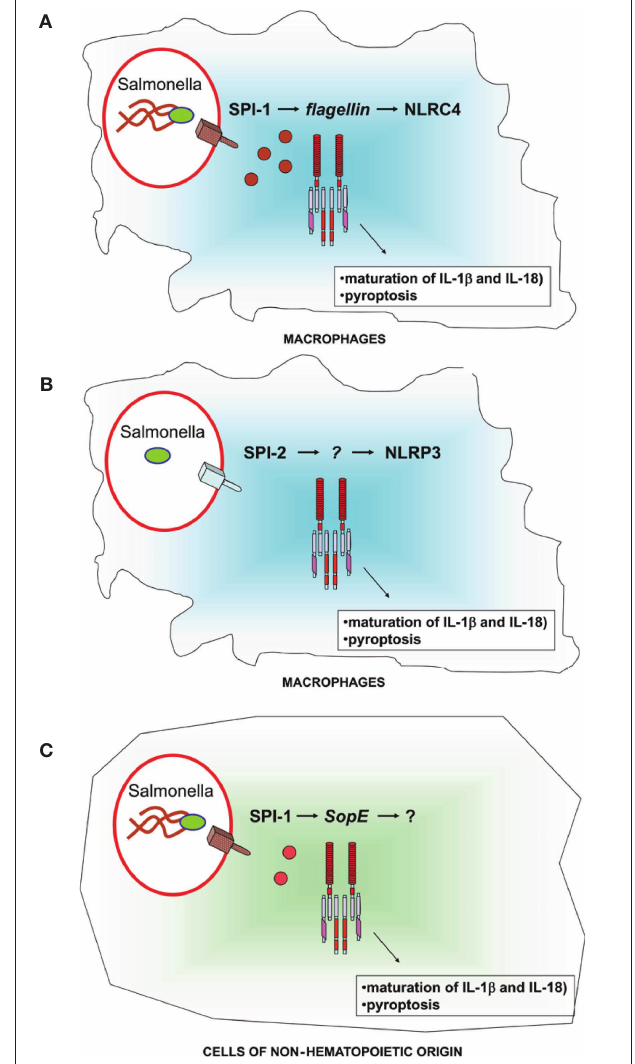
FIgure 1 | Schematic representation of the pathways leading to caspase-1 activation in cells infected with Salmonella . In macrophages (A,B) Salmonella induces the activation of the NLRC4-inflammasome via flagellin and SPI-1 (A) and the NLRP3-inflammasome via SPI-2. (C) In cells of non-hematopoietic origin Salmonella induces the activation of the inflammasome via SopE and SPI-1. See text for more